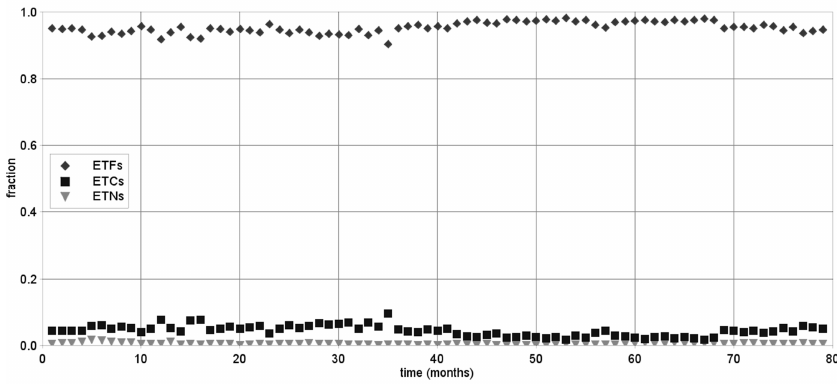
Figure 5. Market shares of exchange-traded funds, exchange-traded commodities and exchange-traded notes in Germany (share in the total turnover of exchange- traded products, monthly data for